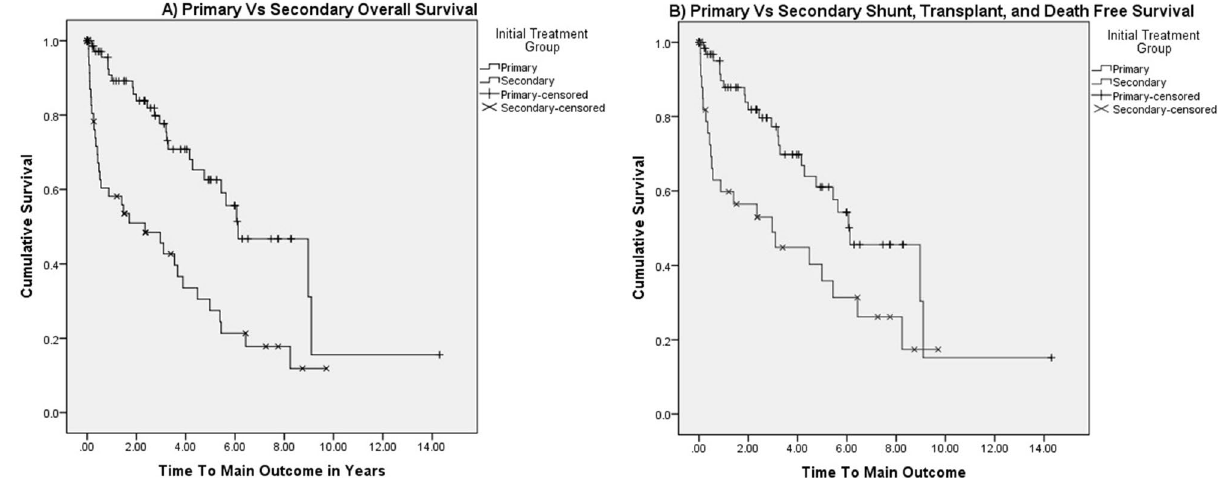
Figure 2. ( a ) Kaplan–Meier Overall Survival Curve for Primary and Secondary Endoscopic Prophylaxis excluding CTPV/PTV (log-rank p = 0.017). ( b ) Kaplan–Meier Survival Curve without portosystemic shunt or liver transplant for Primary and Secondary Endoscopic Prophylaxis excluding CTPV/PTV (log-rank p =